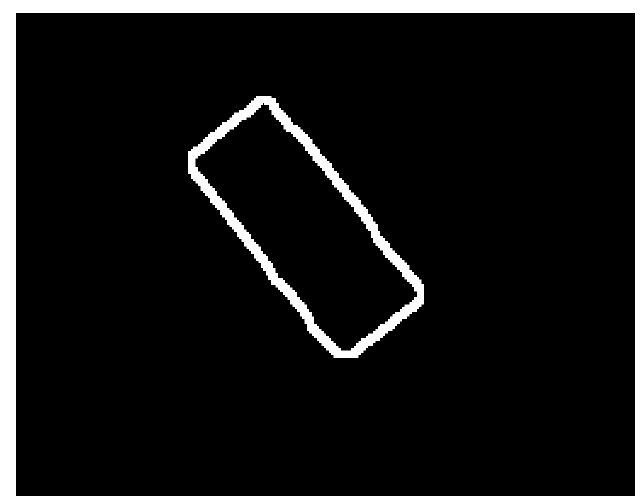
Figure 4. Result obtained after processing from step 3.